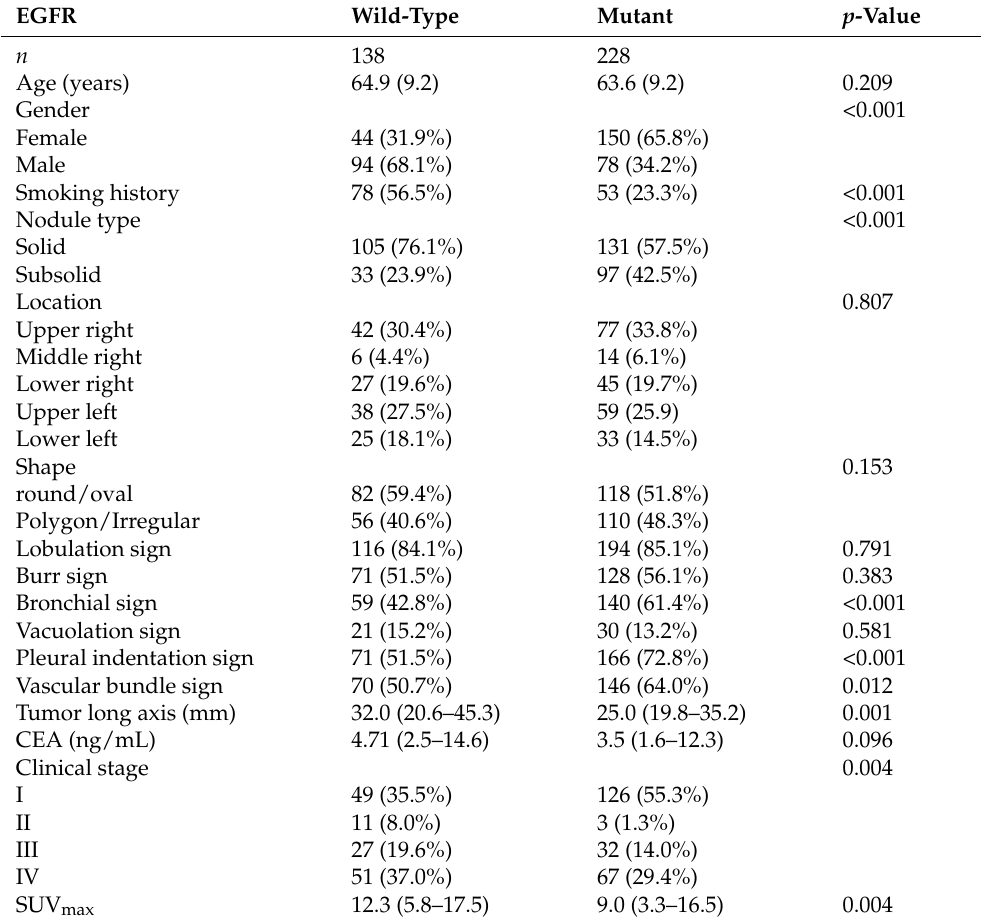
Table 1. Comparison of general data and imaging parameters between EGFR mutant and wild- type